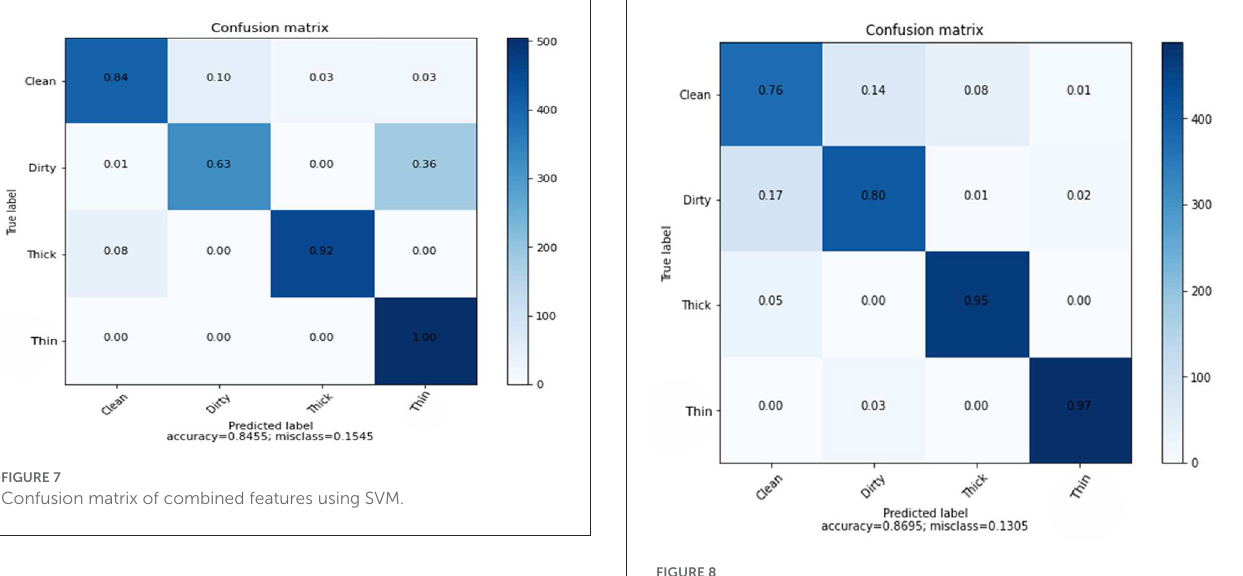
FIGURE8 Confusion matrix of GLCM features using KNN.